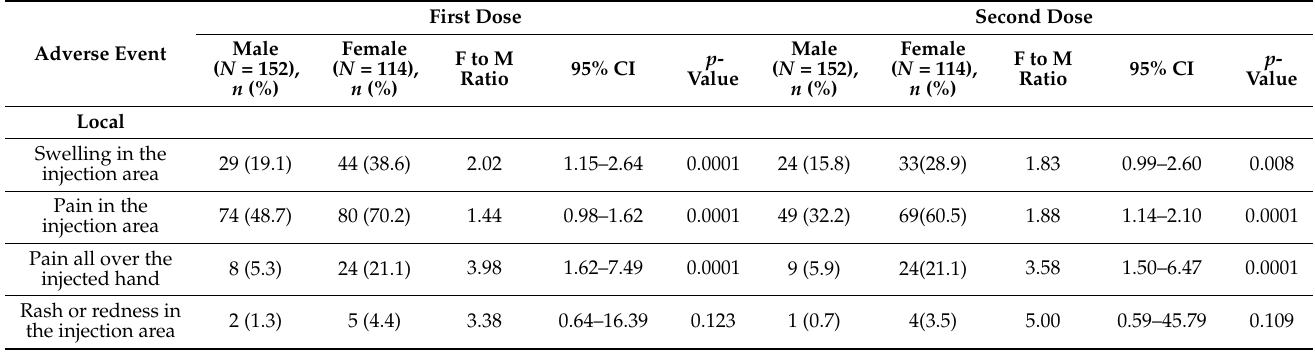
Table 3. Female-to-male ratio of the percentage reporting adverse events following the Pfizer- BioNTech COVID-19 vaccine and lasting more than 24 h, in a cross-sectional